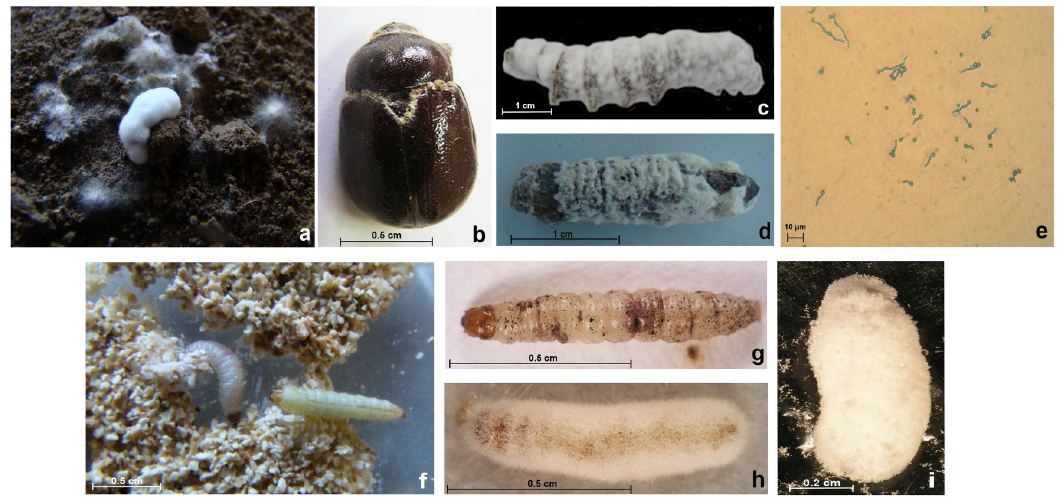
Fig 3. The collected insects infested by Beauveria bassiana , with the degrees of FDI on Ephestia kuehienella larvae. (a) infected larva of Ephestia kuehniella in soil trap method; (b) Phyllognathus excavatus adult ( ♀ ) infected with Beauveria bassiana ; (c) Bombyx mori larva infected with B . bassiana ; (d) Paropta paradoxa larva infected with B . bassiana ; (e) Germination of B . bassiana spores; (f) Healthy larvae of E . kuehienella (3 rd instar); (g) larva of E . kuehienella with milanic spots (FDI = 0.5); (h) dead larva of E . kuehienella covered with mycelium growth (FDI = 2); (i) larva of E . kuehienella covered with B . bassiana growth in full sporulation (FDI =